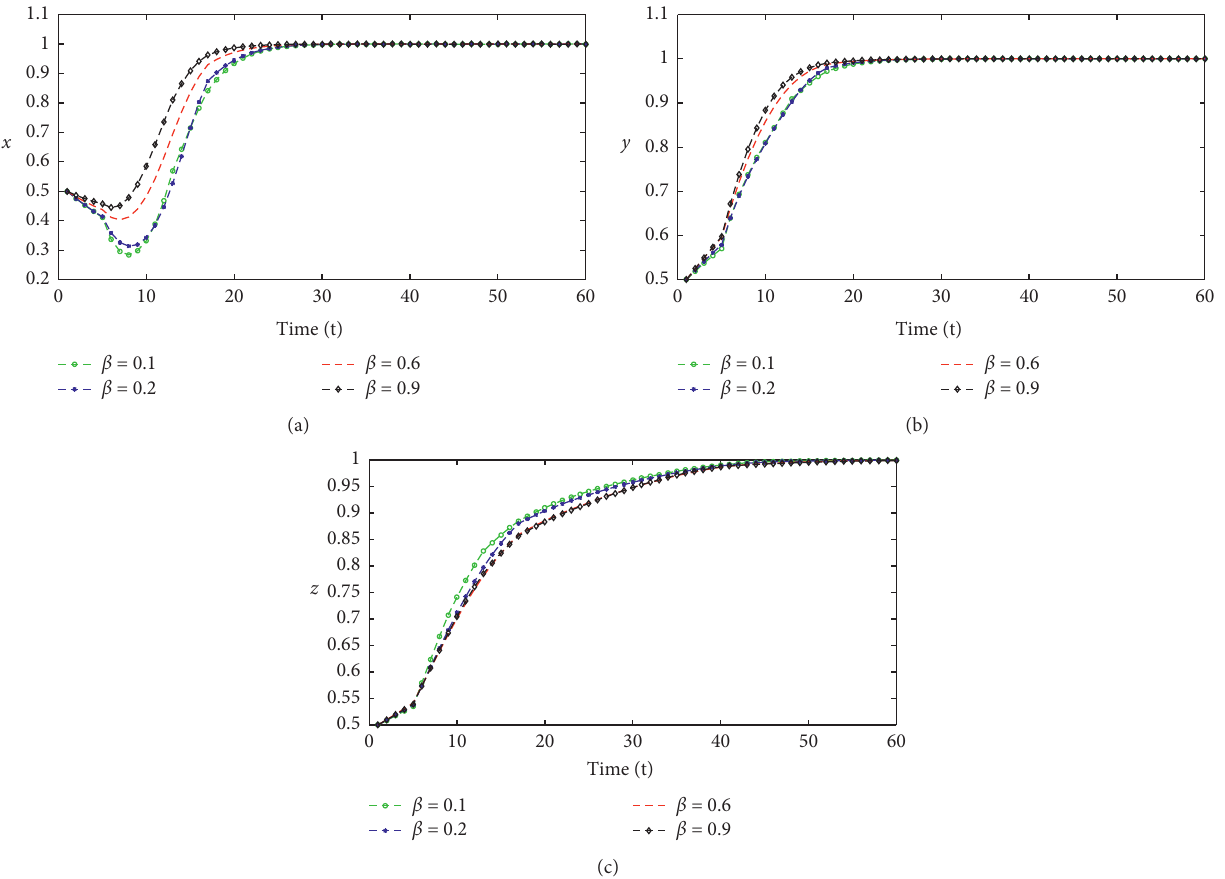
Figure 3: The effect of the carbon tax rate on the evolutionary strategies.